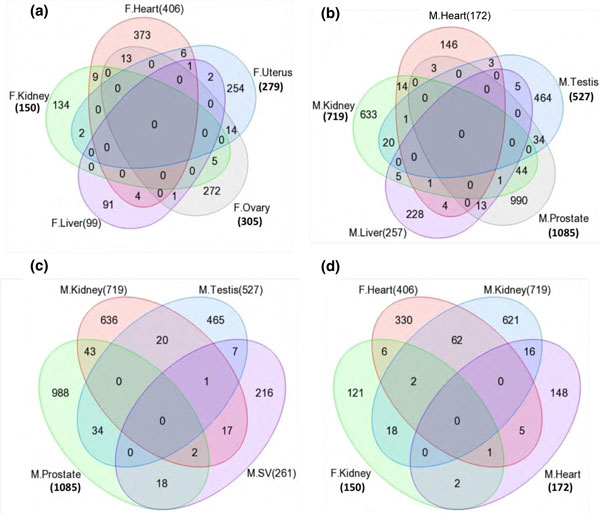
Venn diagrams of male and female tissue signature lists of F3 generation vinclozolin lineage
differentially expressed genes. (a) Female (F) heart, kidney, liver, uterus, and ovary.
(b) Male (M) heart, kidney, liver, testis, and prostate. (c) Male kidney, testis,
seminal vesicle (SV), and prostate. (d) Female heart and kidney and male heart and kidney.
Numbers in brackets are the total number of genes in the signature list.